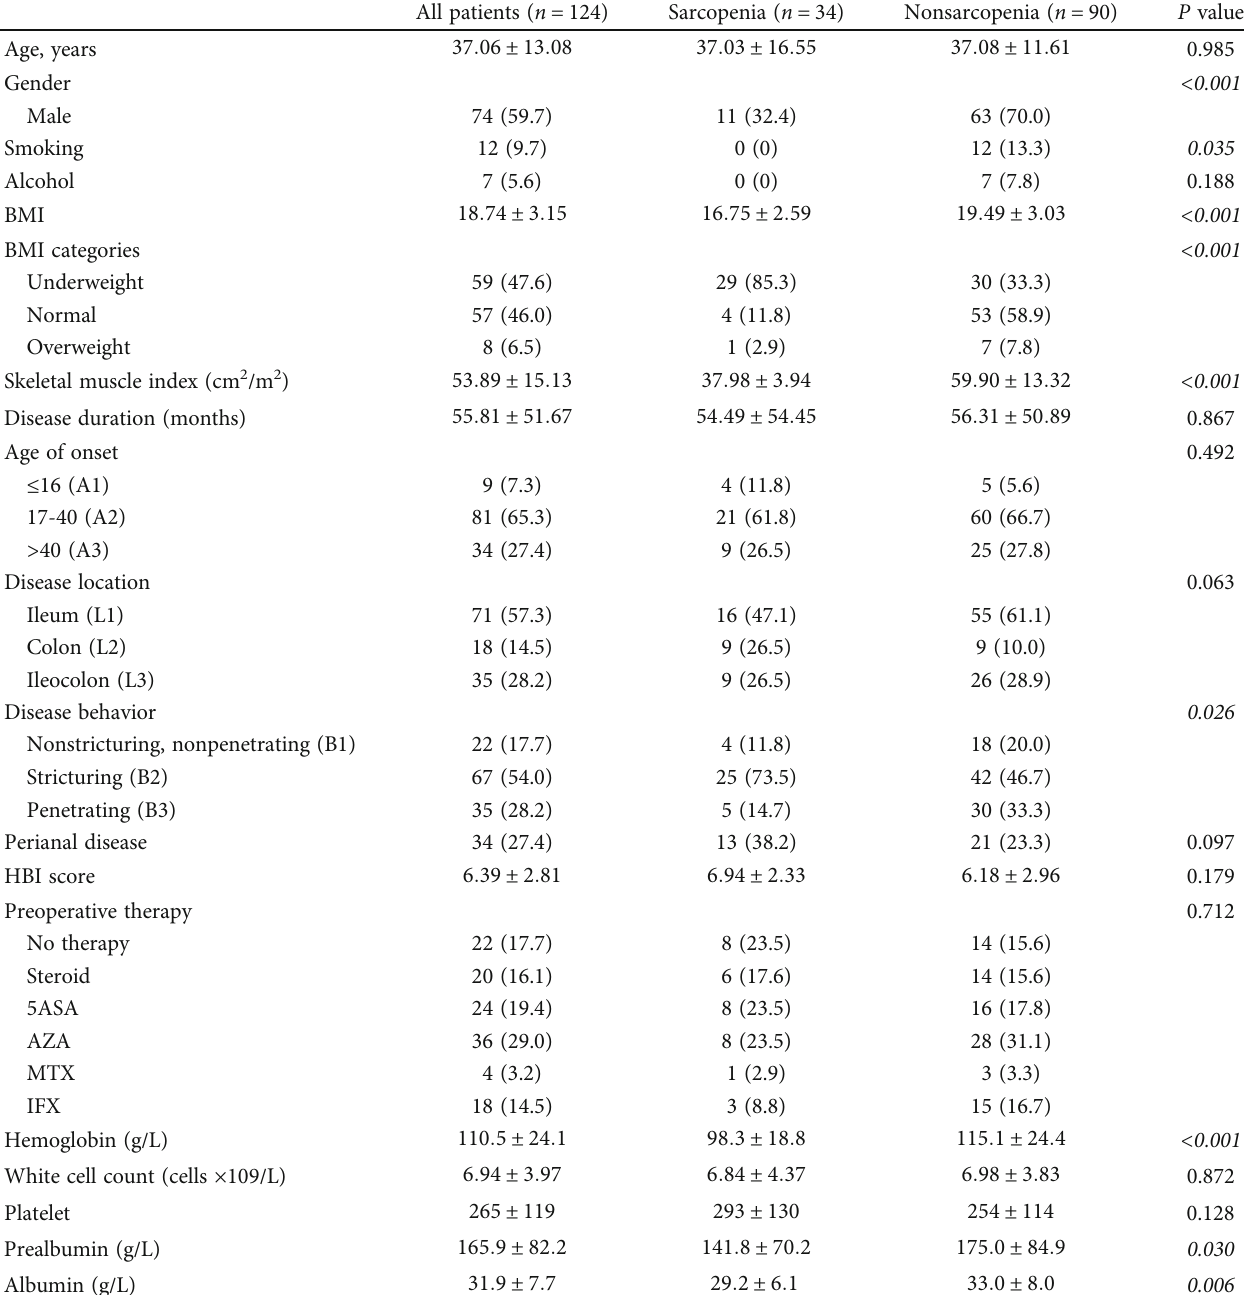
Table 1: Demographic and clinical characteristics in CD patients with or without